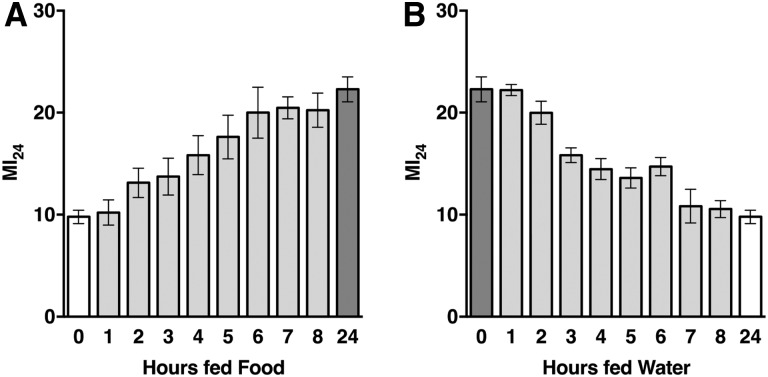
The duration of feeding water and food following primary injuries affects the MI24 of younger w1118 flies. (A) Flies were fed food for the indicated amount of time following primary injuries and water for the remaining time up to 24 hr. (B) Flies were fed water for the indicated amount of time following primary injuries and food for the remaining time up to 24 hr. White bars represent 24 hr fed water, dark gray bars represent 24 hr fed food, and light gray bars represent a mixture of time fed water and food. Each data point is the average and SEM of at least three biological replicates. In (A), the 4, 5, 6, 7, 8, and 24 hr time points were significantly increased compared with the 0 hr time point (P < 0.05, one-tailed t-test). In (B), the 3, 4, 5, 6, 7, 8, and 24 hr time points were significantly decreased compared with the 0 hr time point (P < 0.05, one-tailed t-test).